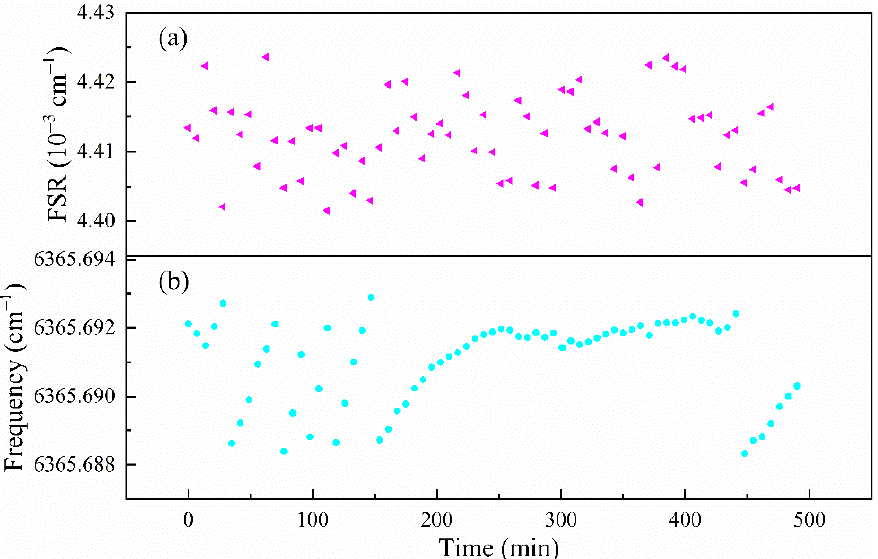
Figure 7. ( a ) Repeated measurements of the FSR value of the ringdown cavity and ( b ) the slow drift of one of the cavity resonance frequencies as a result of optical cavity length drift. The large step change of about 0.0044 cm − 1 is due to the FSR periodicity in resonance frequency assignment.